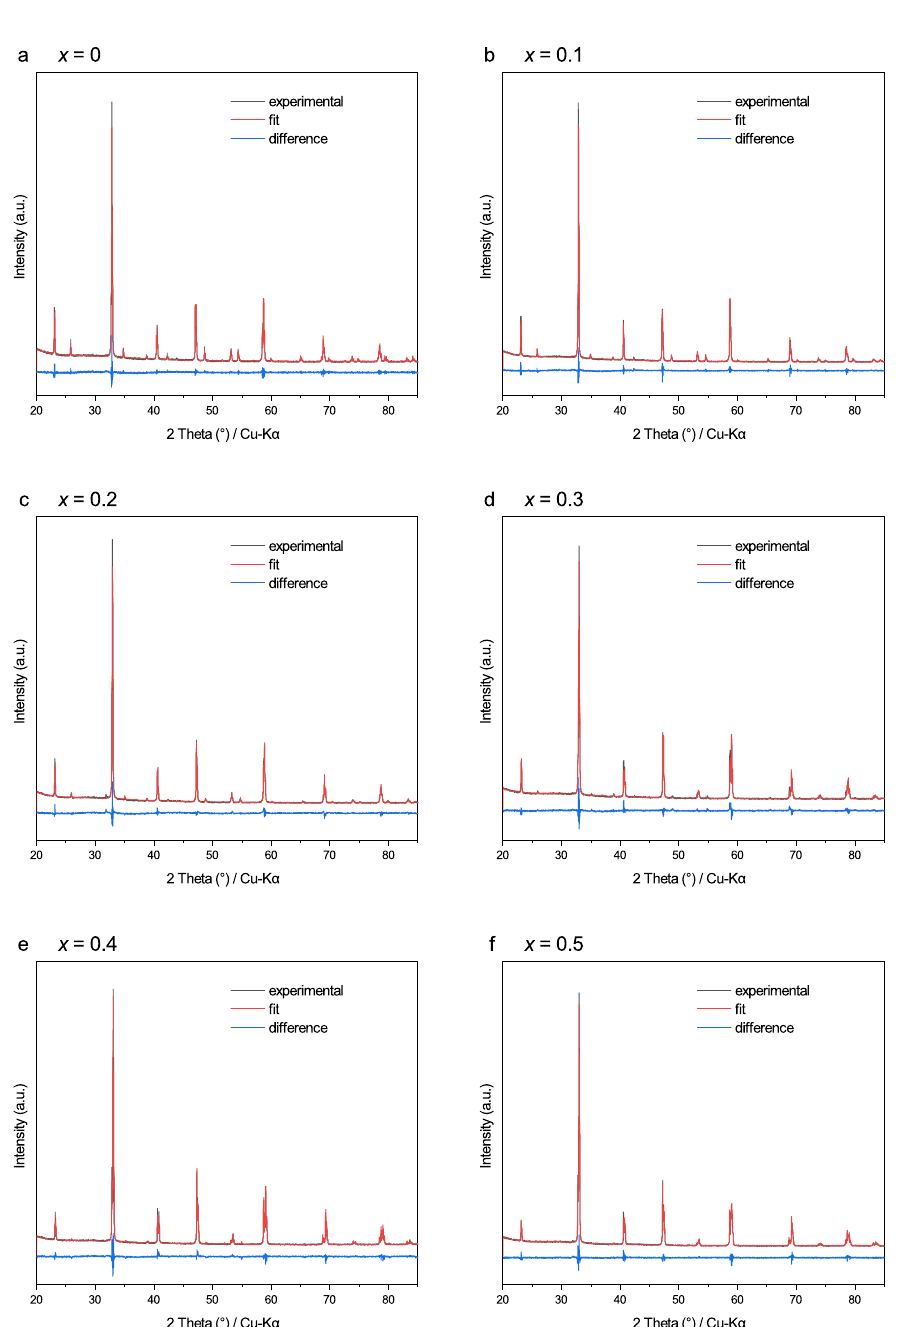
Figure A1. Rietveld refinements of Pr 1– x Sr x (Cr,Mn,Fe,Co,Ni)O 3– δ ( x = 0–0.5) powders treated at 1673K. PrCrO 3 ( Pnma , ICSD 251098) was used as starting structure since the powders are pure phase after heating at 1673K, as discussed in Section 3.1 in the main